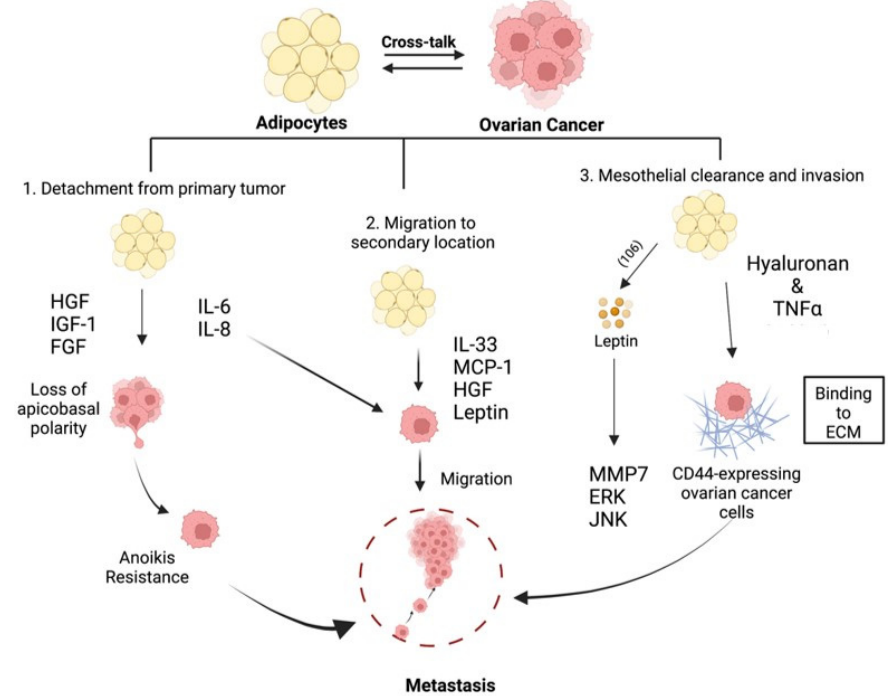
Figure 2. Adipose-induced mechanisms supporting metastasis formation. Adipose-derived factors are able to promote EMT, anoikis resistance, migration, and invasiveness to support all facets of metastasis formation [14,67,68,74,75,77,79–86,91–94,96,97,99,100,104]. Created with Biorender.com (accessed on 1 April 2022).